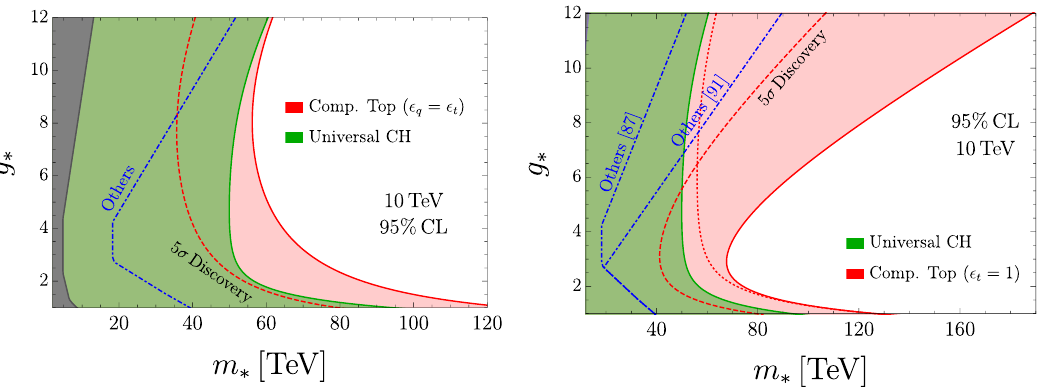
Figure 11. 95% exclusion reach for the two partial compositeness scenarios under consideration. The green shapes represent the combined bound from the flavor universal measurements, while the red contours also includes the di-top and di-bottom constraints. The projected sensitivity of other future collider projects and the gray band of HL-LHC are taken from ref. [87]. The right panel ( (cid:15) = 1 ) also includes the stronger CLIC sensitivity estimated in ref. t